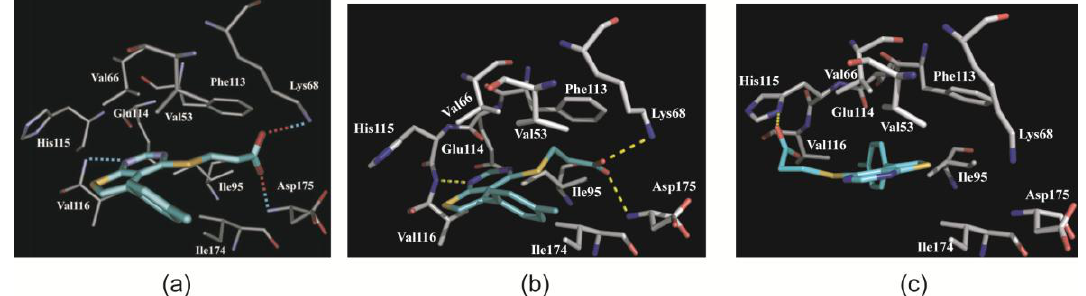
Figure 7. Comparison of modelled and experimental complex structures of TTP22 with CK2 α . ( a ) In-silico model of a CK2 α /TTP22 complex [29]. The picture was reproduced from Golub et al. [29] with kind permission by Elsevier B.V; ( b ) The same section and orientation as in ( a ), but now obtained from the experimental low-salt CK2 α 1–335 /TTP22 complex structure (No. 5 of Table 1); ( c ) The same section and orientation as in ( a ) and ( b ), but now obtained from the experimental high-salt CK2 α 1–335 /TTP22 complex structure (No. 6 of Table 1). Pictures ( b ) and ( c ) were designed in a similar style as panel ( a ) in order to enable easy comparisons.